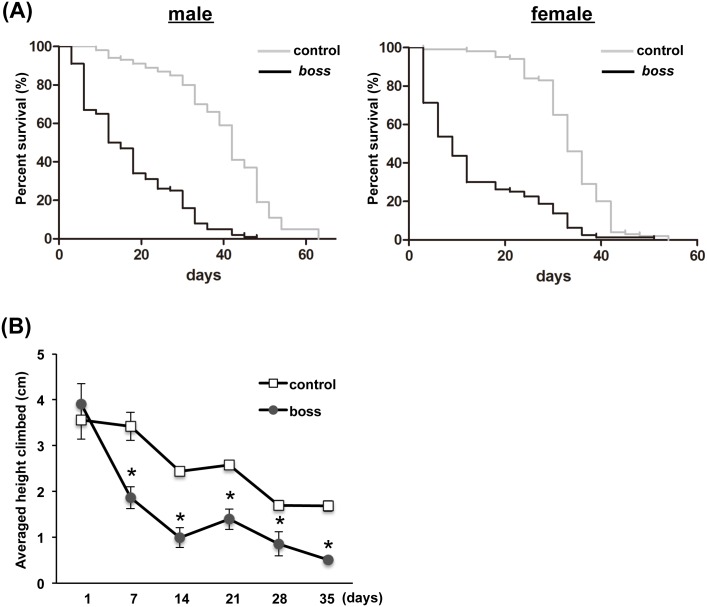
Aging is accelerated in boss mutant flies.(A) Lifespan for male and female boss mutant flies. boss mutant flies have shorter lifespan than control flies. Survival was presented by Kaplan Meier curves of control and boss mutant flies. n = 100 for each genotypes. Median survival for control male = 40days, boss mutant males = 13.5 days, control female = 33days, boss mutant females = 9days (Log-rank test, p<0.0001). (B) Analysis of vertical distance climbed in the rapid iterative negative geotaxis assay of boss mutant and control (w) male flies (n = 3 groups; each group contains 10 flies per genotype per time point). Data are means ± SEM, and differences are significant by t-test (*P<0.05).